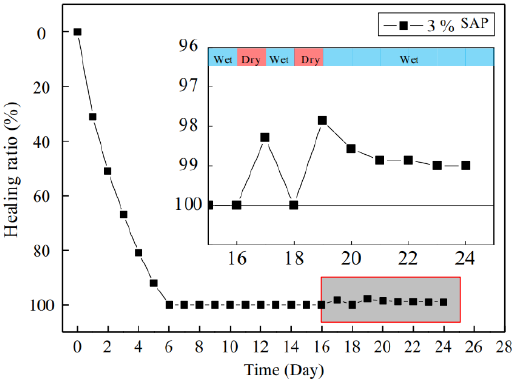
Figure 12. Healing rate of specimens under dry and wet cycle curing. Reprint with the permission from ref. [7]. Copyright 2022